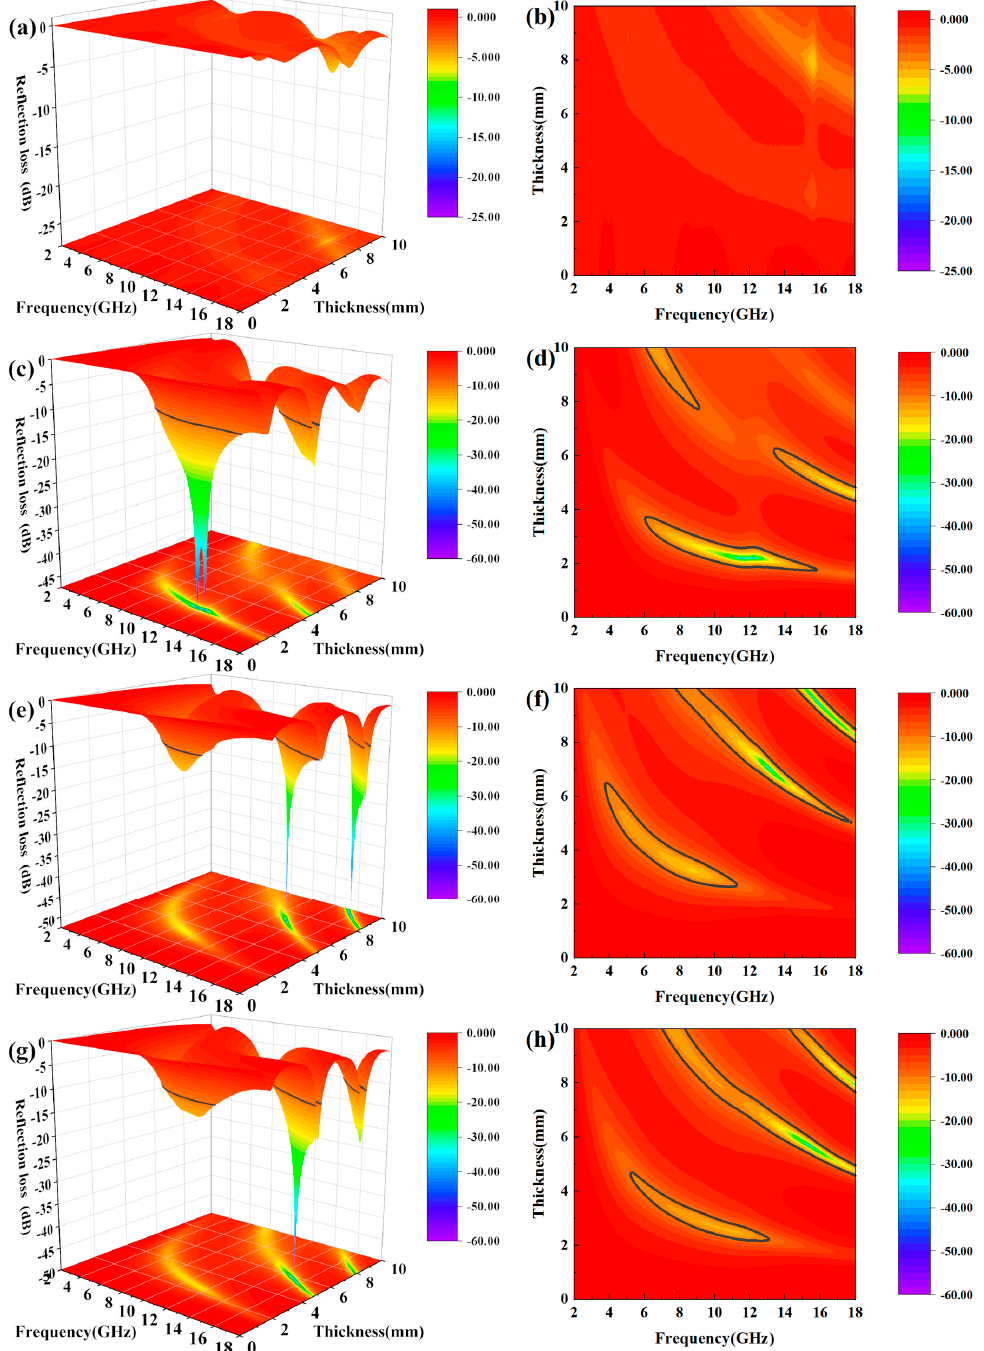
Figure 9. ( a , c , e , g ) Three-dimensional and ( b , d , f , h ) contour-map of reflection loss.